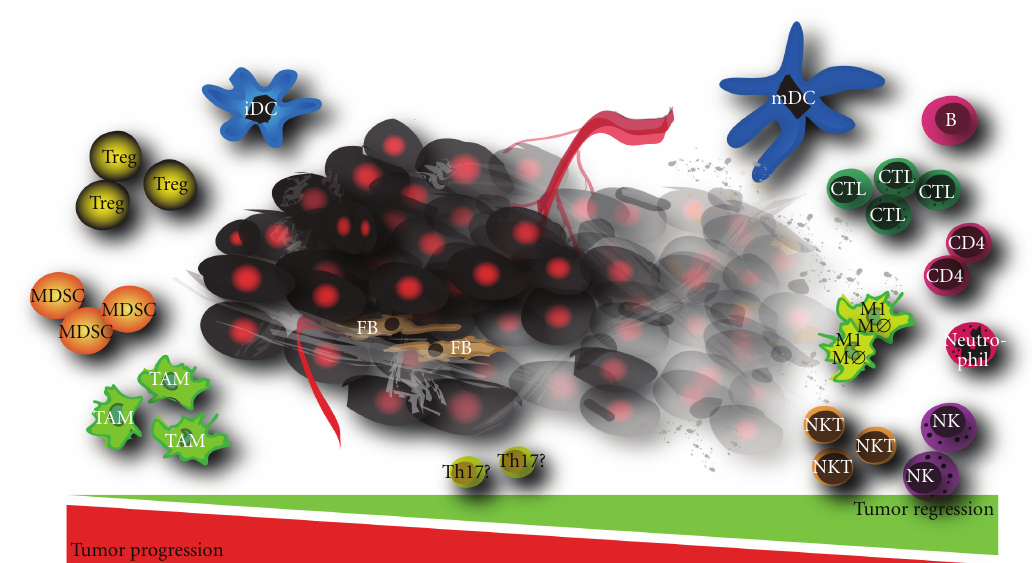
Figure 1: Interplay between immunological cells that inhibit tumour growth on the right of the tumour and cells that aid in tumour progression on the left. (Tumour is depicted as black cells with a red nucleus in the middle.) iDC: immature dendritic cell, Treg: regulatory T cell, MDSC: myeloid-derived suppressor cell, TAM: tumour-associated macrophage, mDC: mature dendritic cell, B: B cell lymphocyte, CTL: cytotoxic T lymphocyte, M1 MØ: M1 macrophage, NK(T): natural killer (T) cell, Th17: helper T lymphocyte 17, FB: